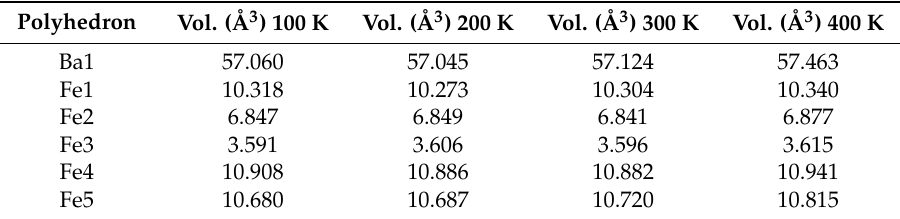
Table 6. Data of polyhedral volumes in the crystal structure of barioferrite at 100, 200, 300, and 400 K.